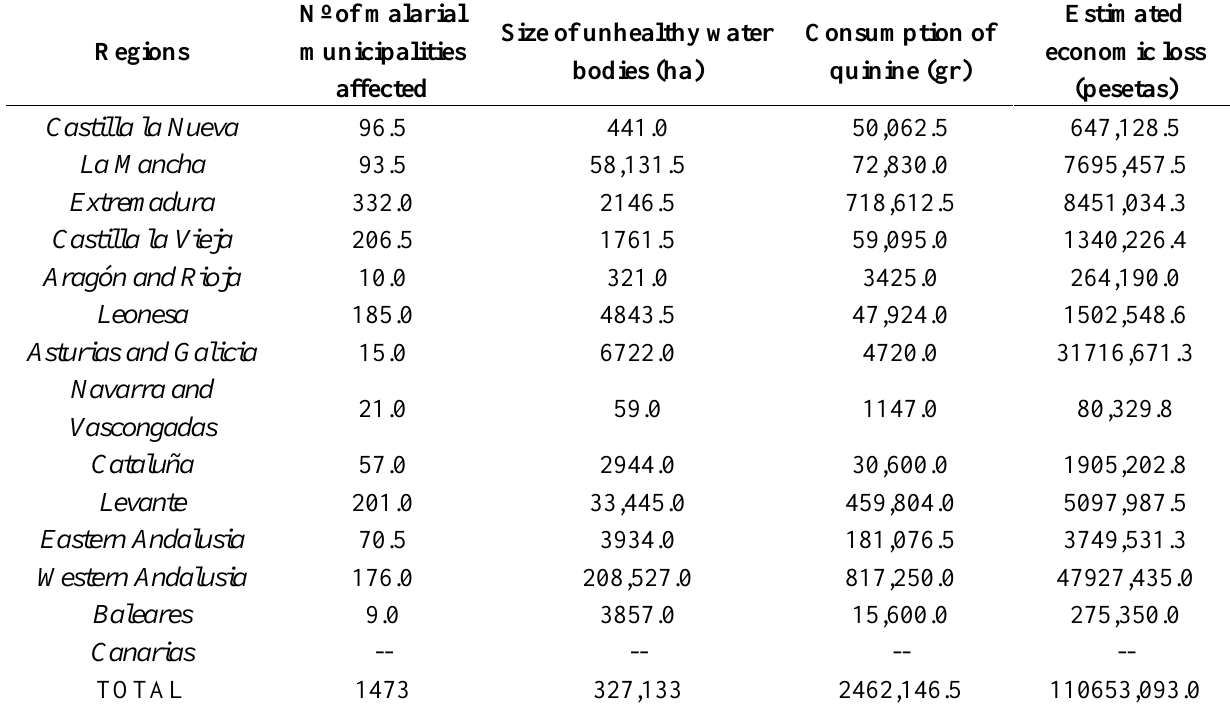
Table 2. Mean values of environmental and sanitary variables related to malaria in Spanish regions in 1913 and